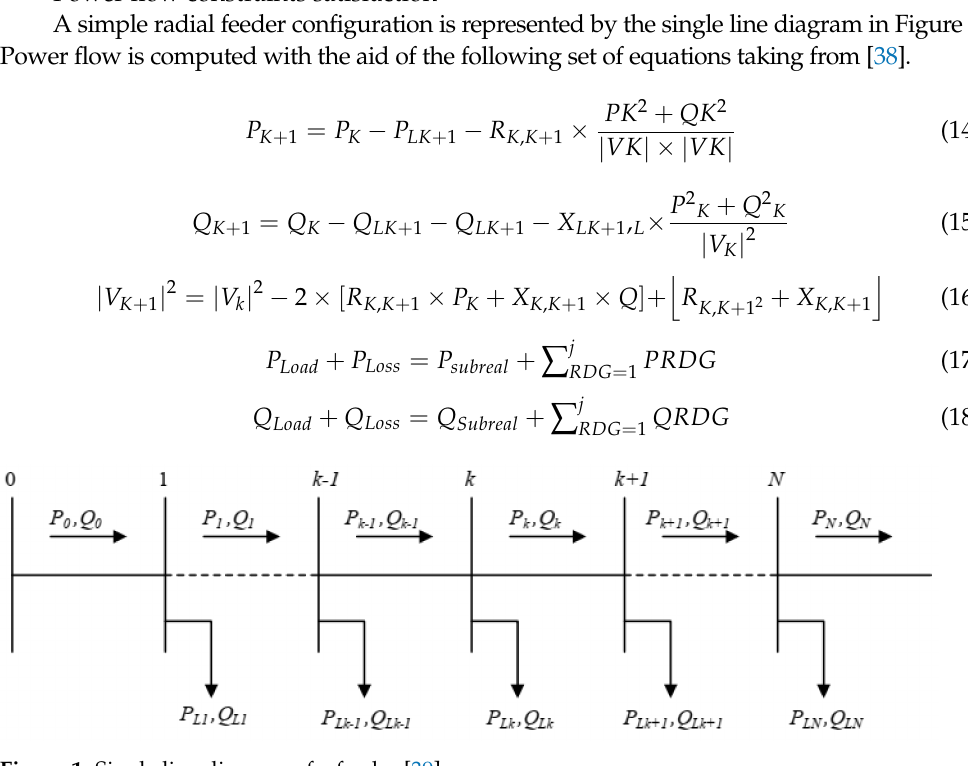
Figure 1. Single line diagram of a feeder